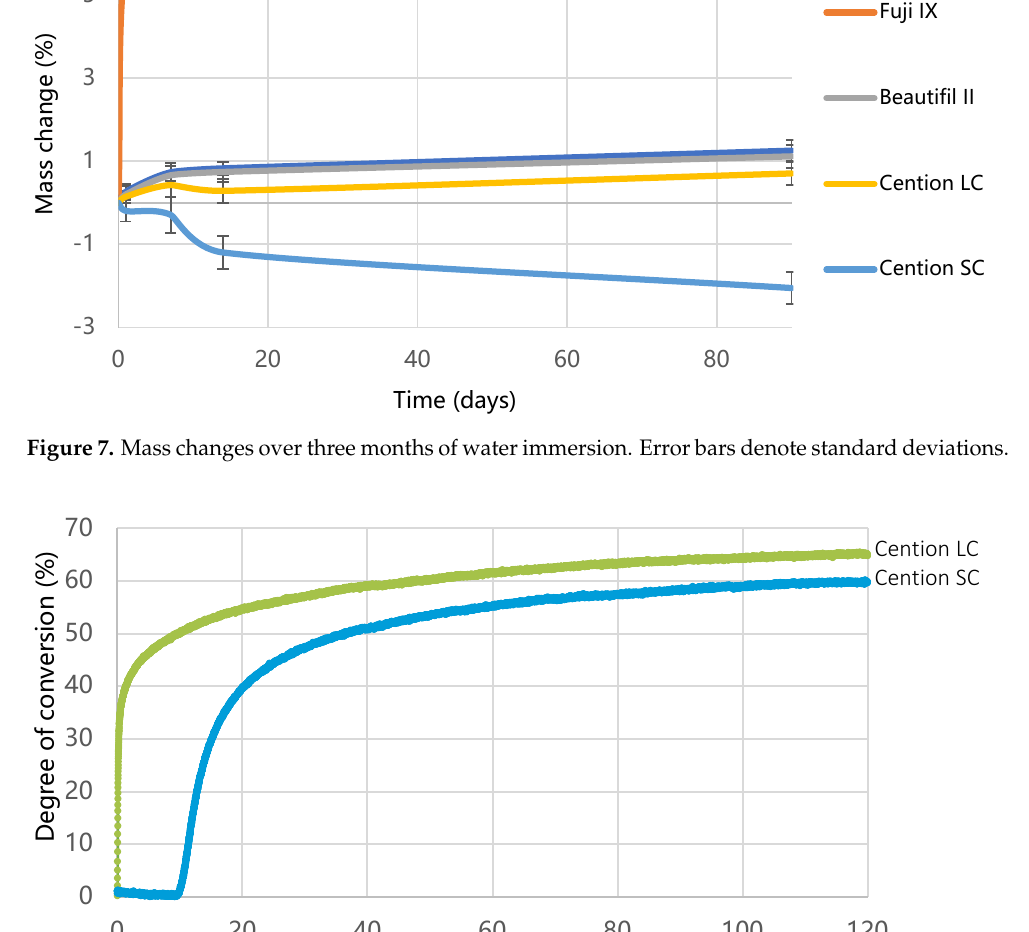
Figure 7. Mass changes over three months of water immersion. Error bars denote standard deviations.